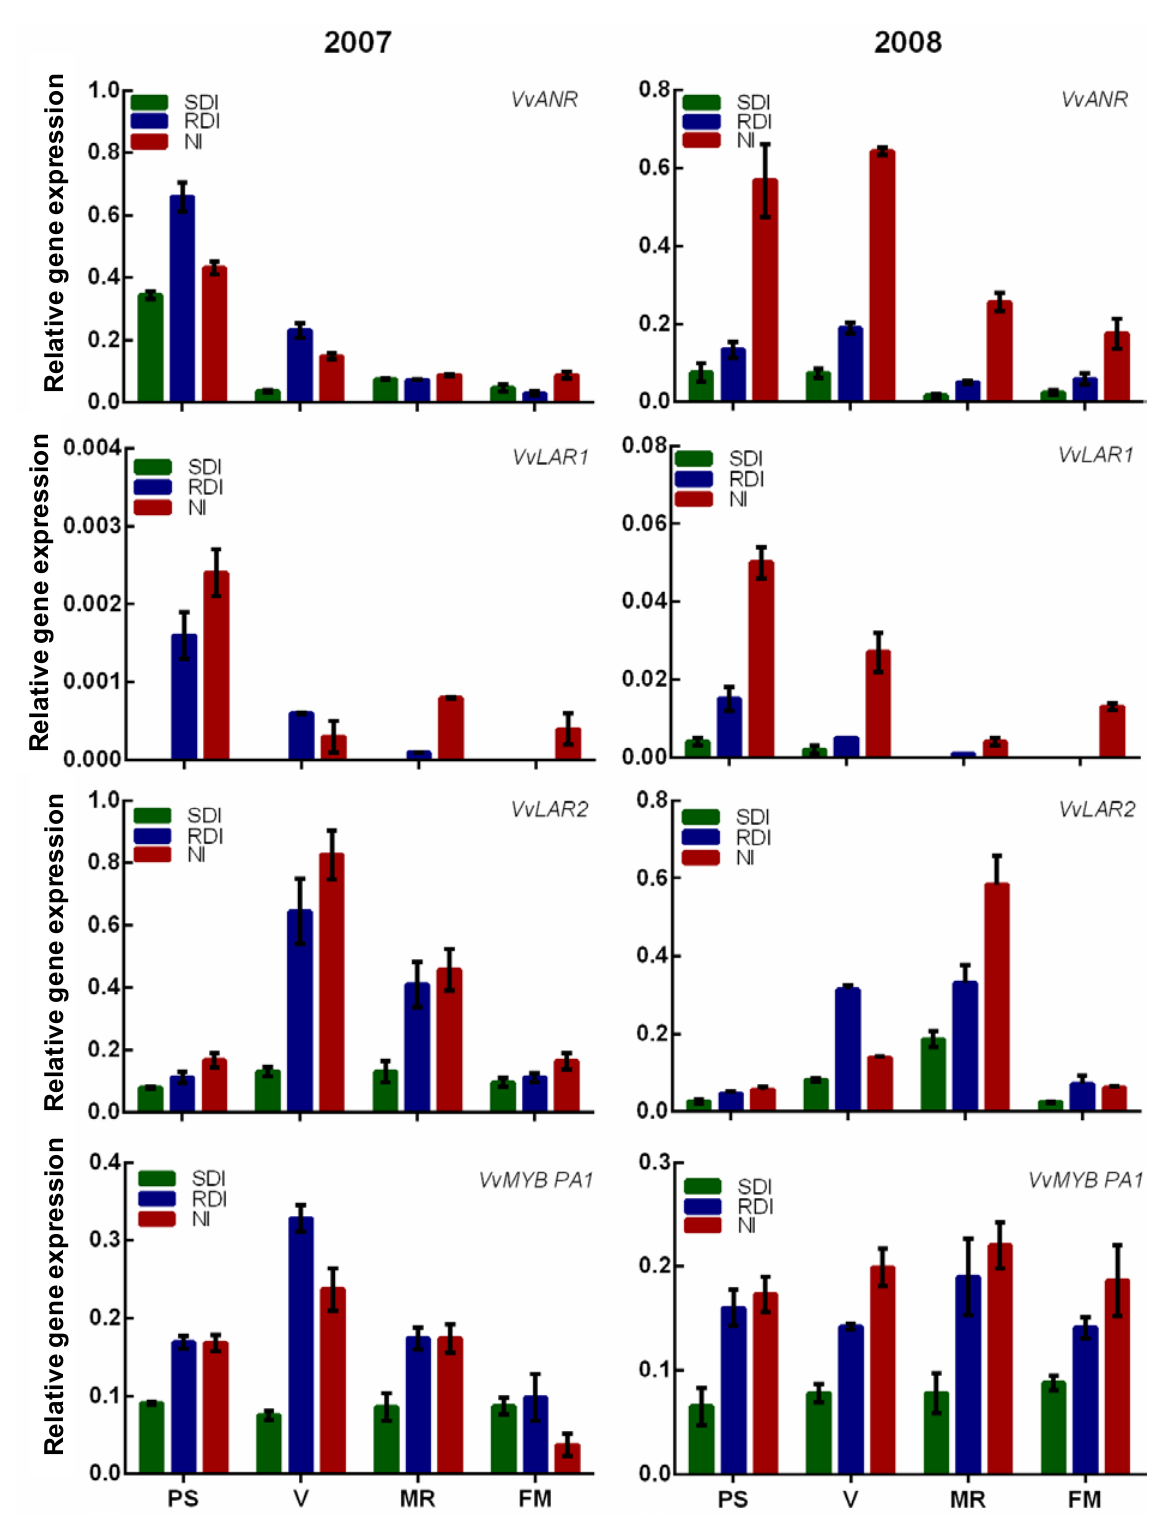
Figure 3. Expression of the genes VvANR , VvLAR1 , VvLAR2 , VvMybPA1 in berry seeds of SDI, RDI and NI treatments in the seasons 2007 and 2008. Values presented are means ± SE ( n ≥ 3). PS: end of pea size (7 weeks after anthesis); V: veraison (9 weeks after anthesis); MR: mid-ripening (11 weeks after anthesis); and FM: full maturation (13 weeks after